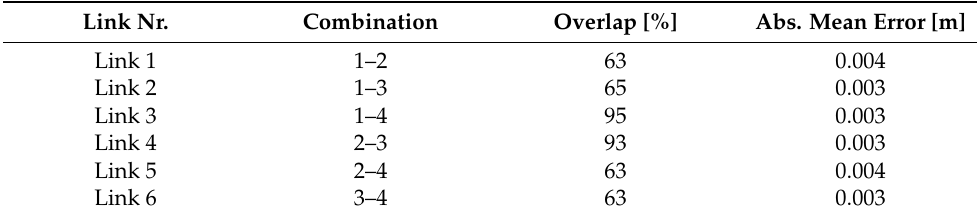
Table 4. Results from the BLK360 laser scanner, the synagogue in the Amezrou. Link